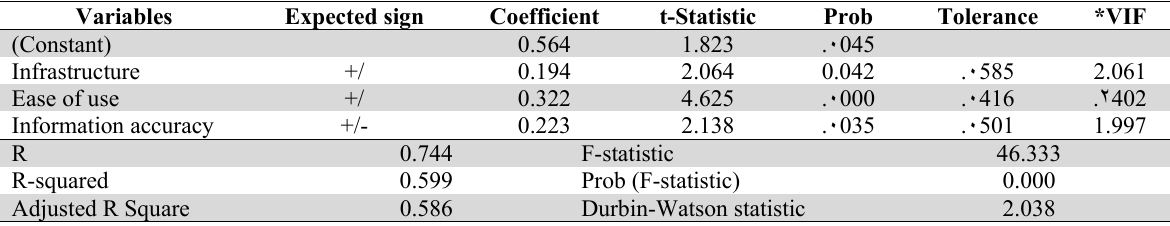
MLR for effect of the OSS on